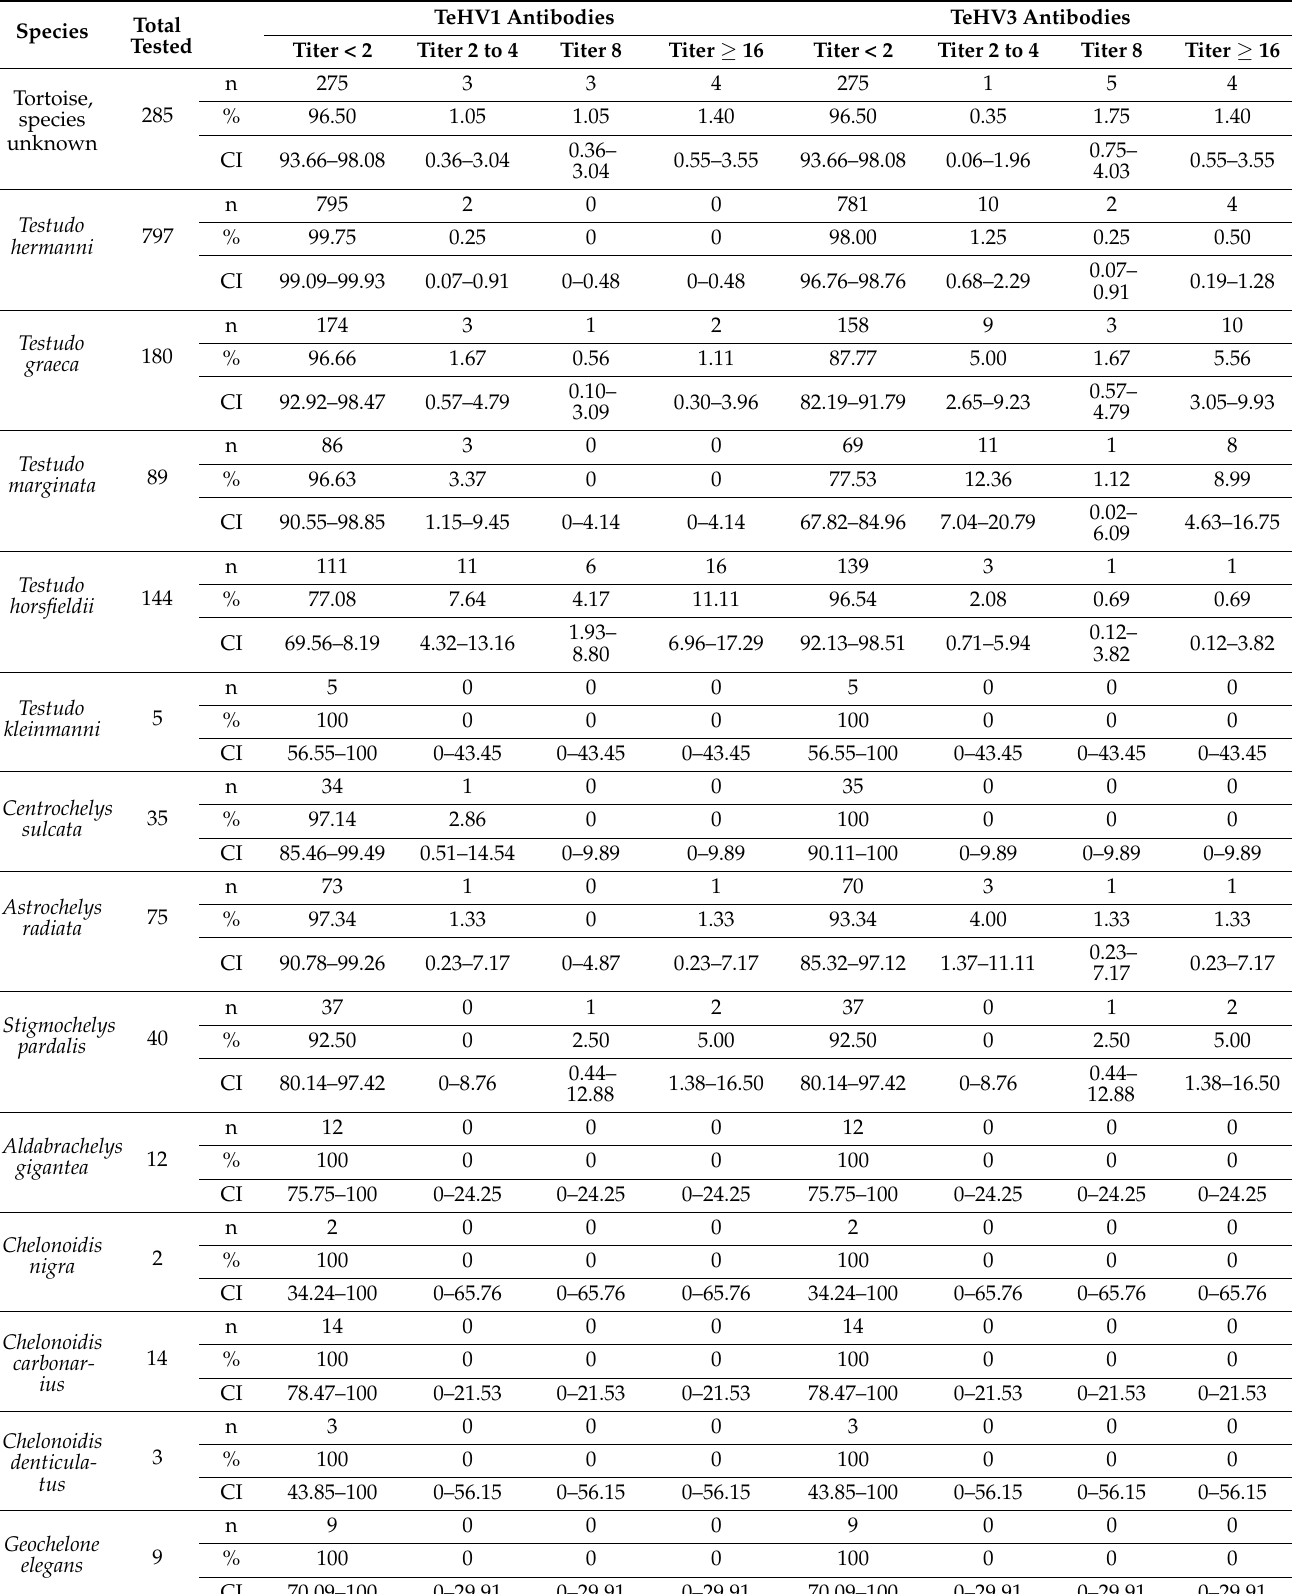
Table 1. Detection rates of antibodies against testudinid herpesvirus 1 (TeHV1) and testudinid herpesvirus 3 (TeHV3) depending on species